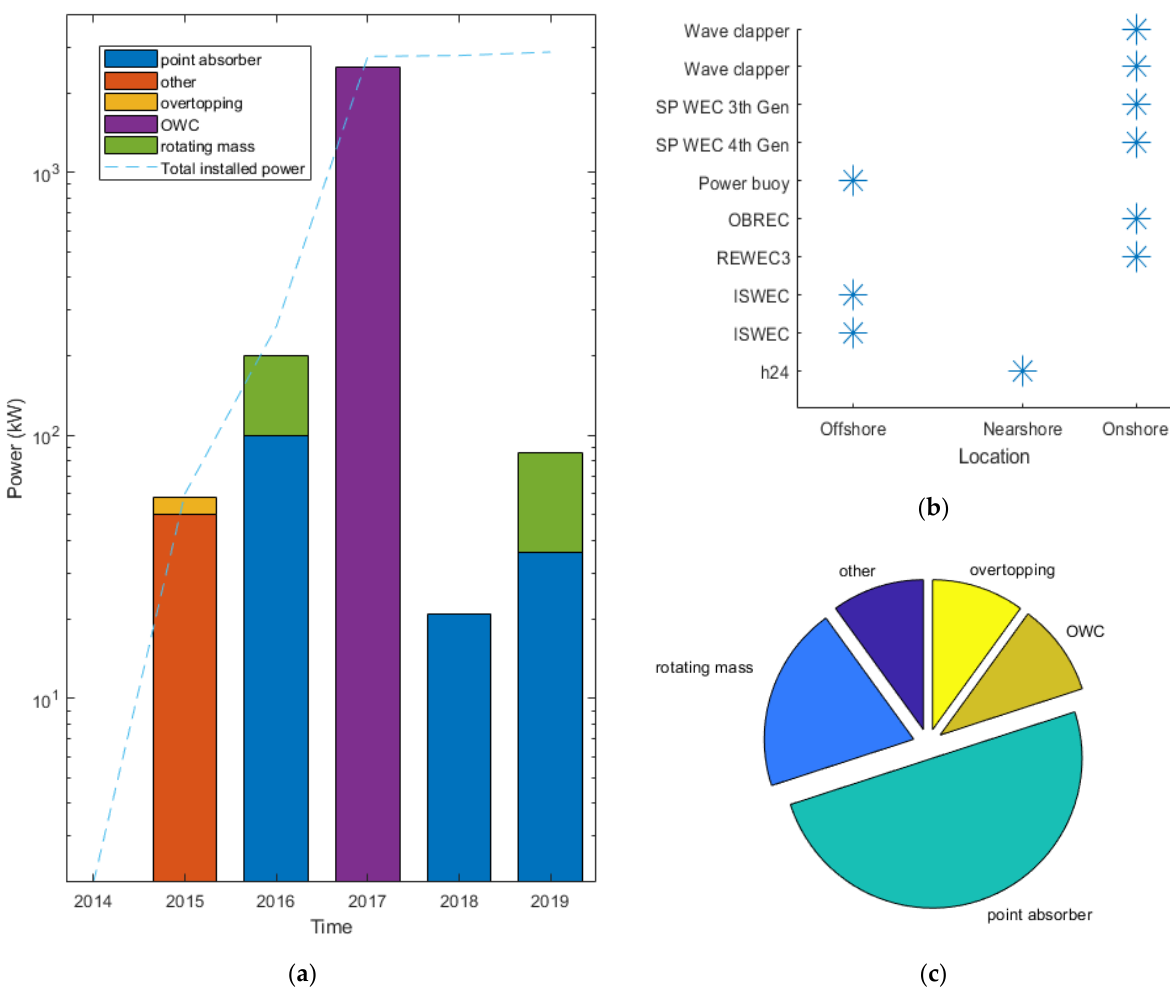
Figure 2. ( a ) Installed power of the five different types of WECs in the Mediterranean Sea; ( b ) location of deployed WECs in the Mediterranean Sea; ( c ) pie chart of the deployed types of WEC in the Mediterranean Sea.